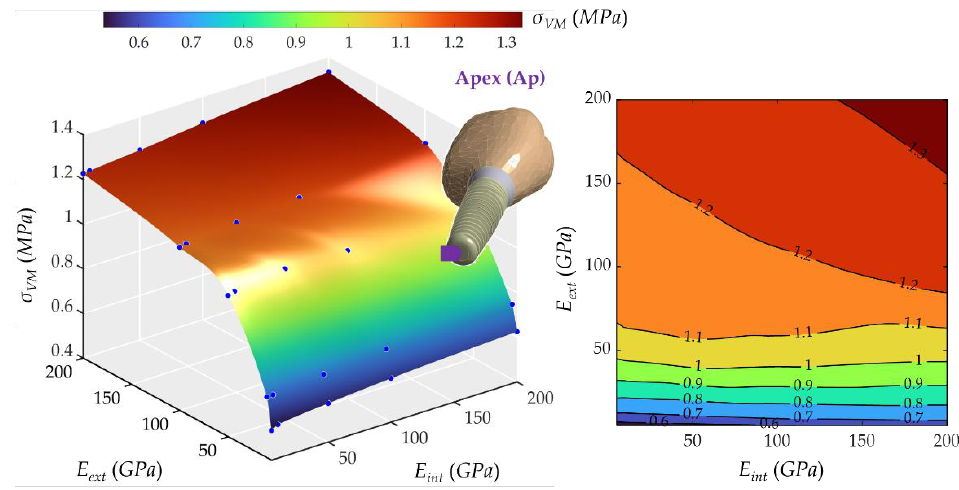
Figure 12. Von Mises maximum stress in the apex (Ap). ( Left ): 3D representation. ( Right ): vertical projection.